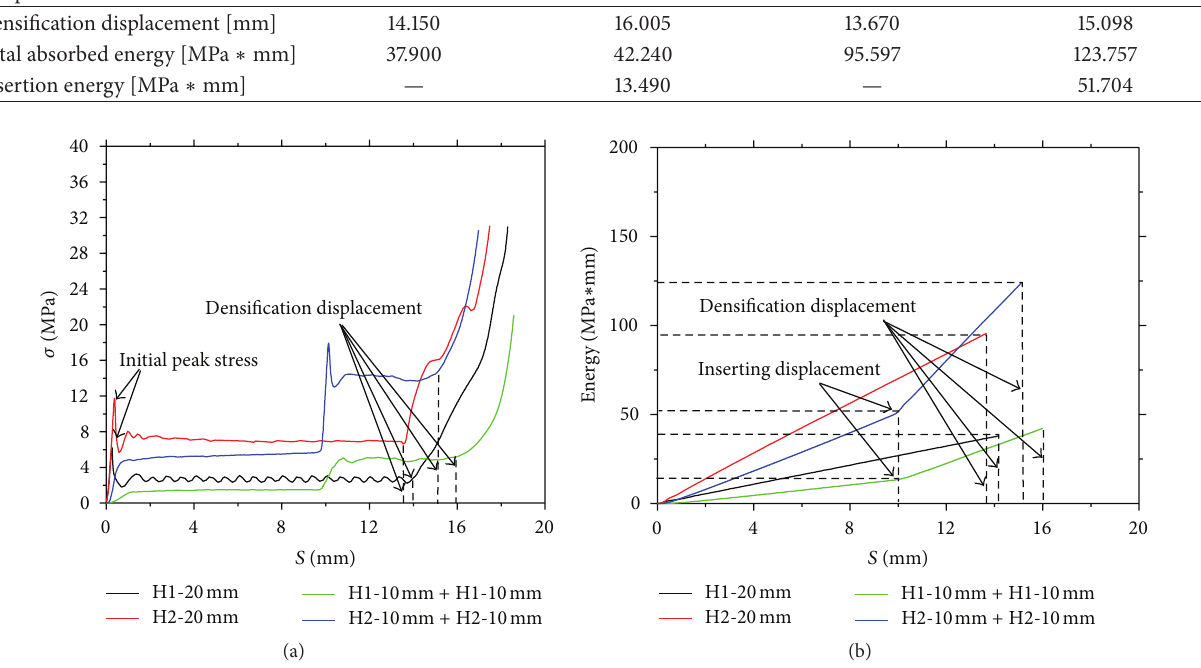
Figure 10: Comparison on the crushing and energy-absorbing property of honeycomb. (a) Crushing property and (b) energy-absorbing